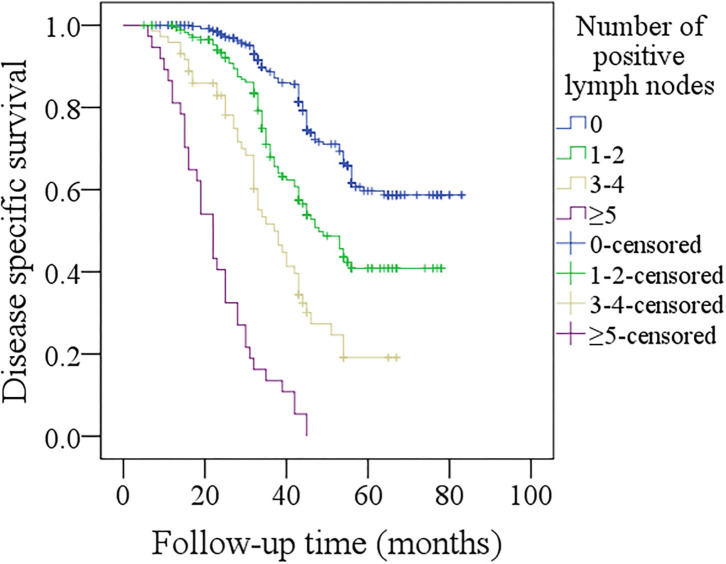
Comparison of disease-specific survival among patients with different numbers of positive lymph nodes (p < 0.001).